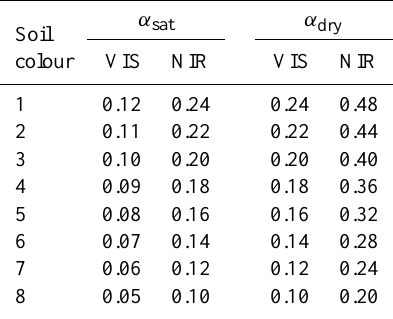
Table 1. Saturated- and dry-soil albedos for different soil colours (Fig. 2c) in the VIS and NIR